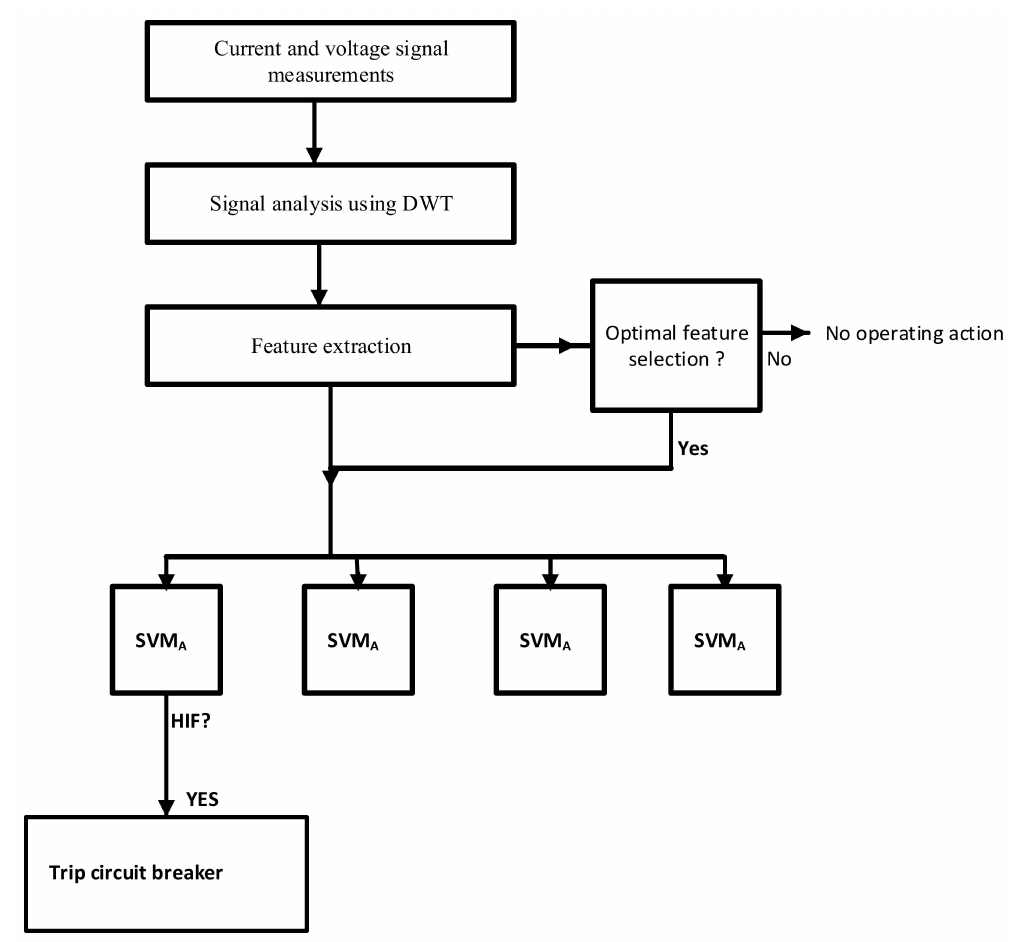
Figure 2. Wavelet transform and support vector machine fault classification scheme.